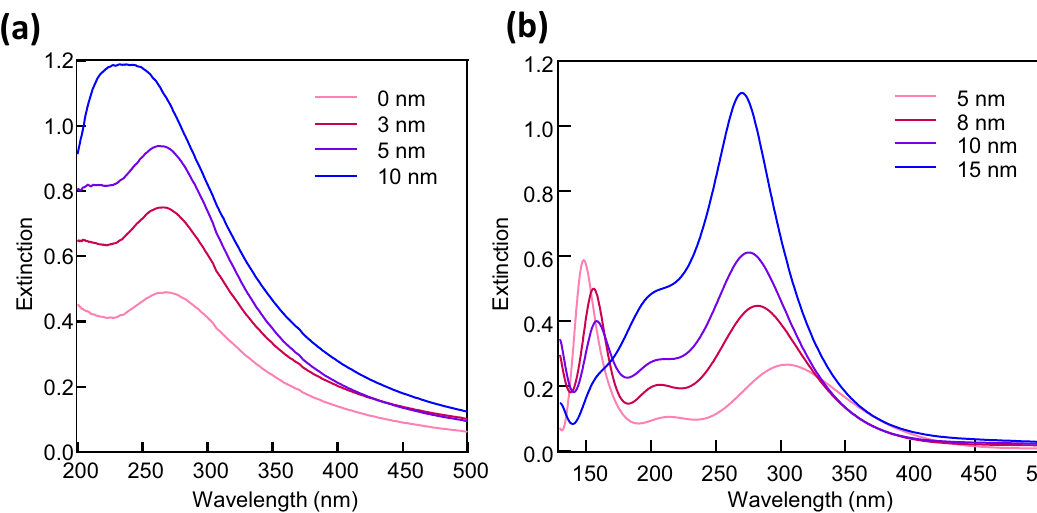
Figure 6. Extinction spectra of the NHoM structure obtained by experimentally and theoretically. ( a ) Experimental extinction spectra of Al NHoM structure. The Al 2 O 3 spacer layer thicknesses were 0, 3, 5, and 10 nm. ( b ) Calculated extinction spectra of Al NHoM structures with Al nanohemisphere diameter of 20 nm. The Al 2 O 3 spacer layer thicknesses were 5, 8, 10, and 15